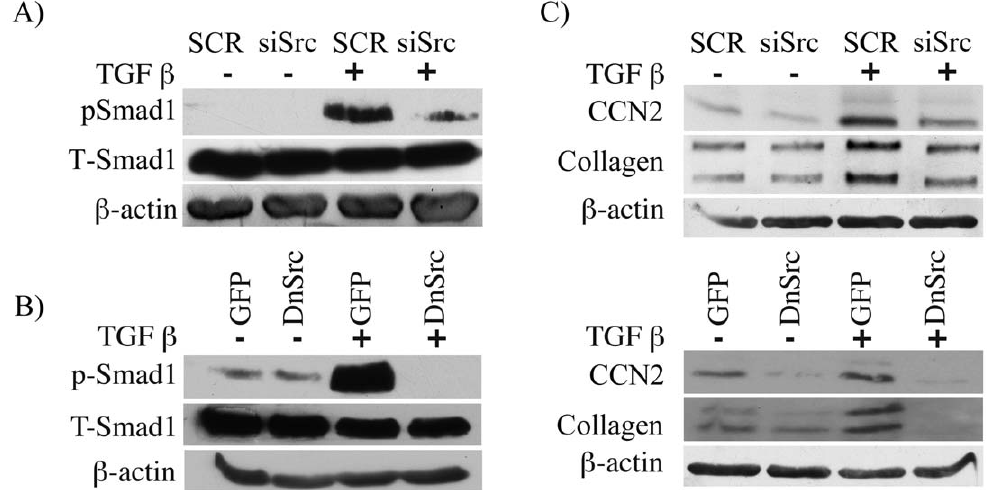
Figure 4. Src mediates TGF- b induced Smad1 phosphorylation. (A) Foreskin fibroblasts were transfected with control (SCR) or Src siRNA oligos. pSmad1 and total Smad1 were analyzed by western blot. (B) Foreskin fibroblasts were transduced with dominant negative Src adenovirus